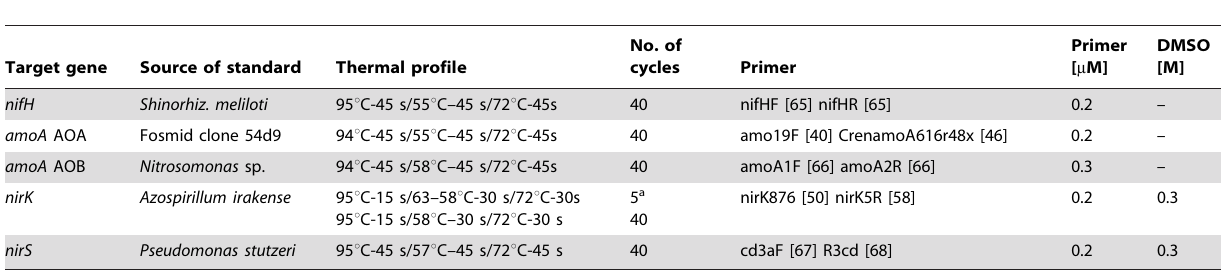
Table 2. Thermal profiles and primer used for real-time PCR quantification of different functional genes.